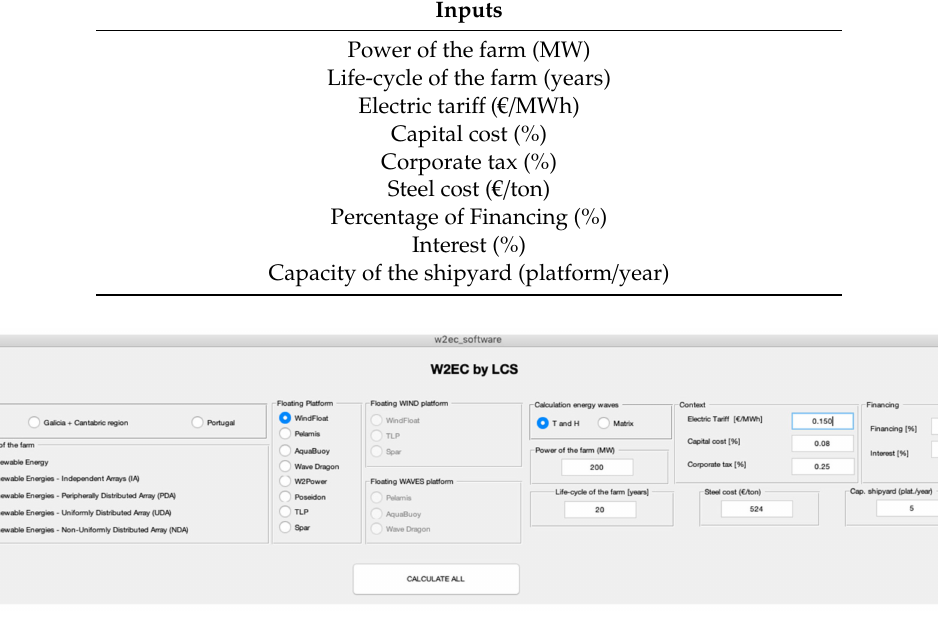
Figure 1. Software